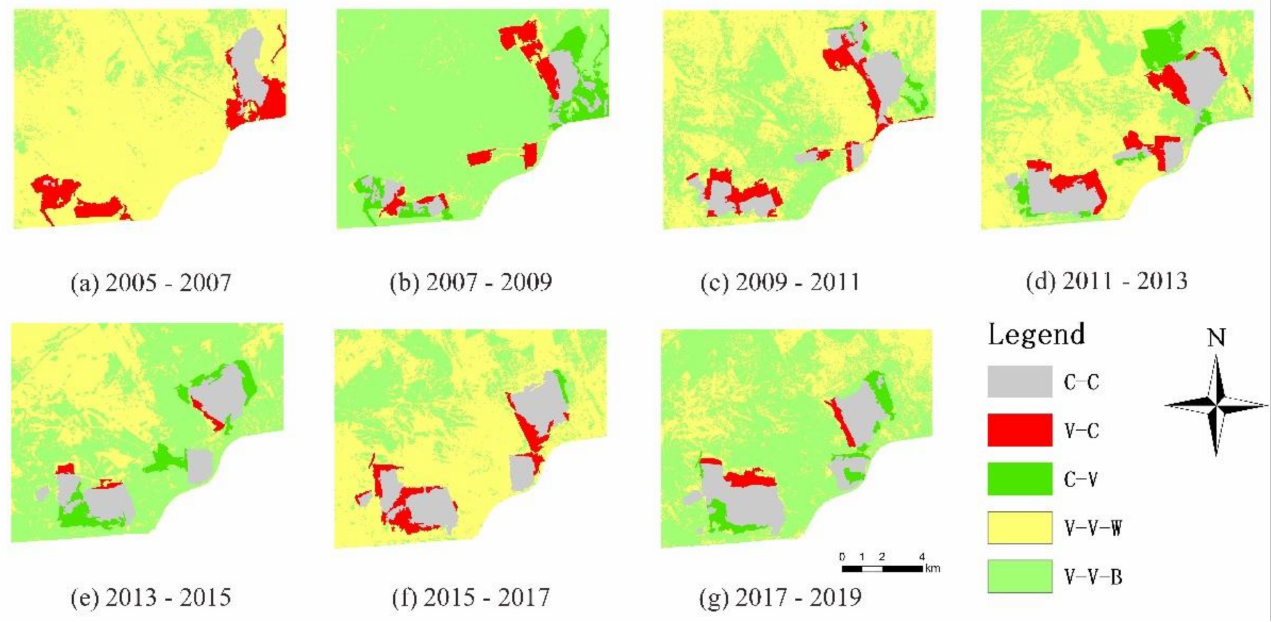
Figure 7. The land type and vegetation changes of the two adjacent periods of data are from 2005 to 2019. ( a ) 2005–2007 ( b